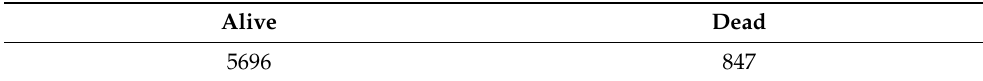
Table 2. Number of sequences of each class (alive/dead) in the original dataset.